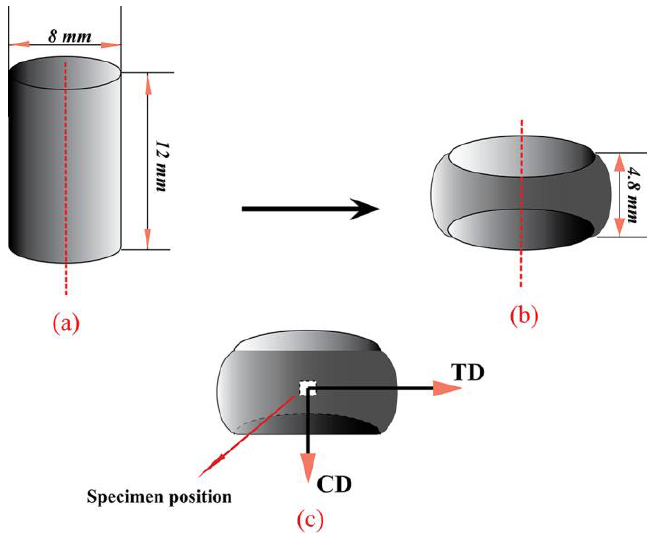
Figure 1. Schematic of isothermal compression and viewing position (CD and TD represents compressing direction and tranverse direction, respectively): ( a ) undeformed sample; ( b ) deformed sample; ( c ) sample